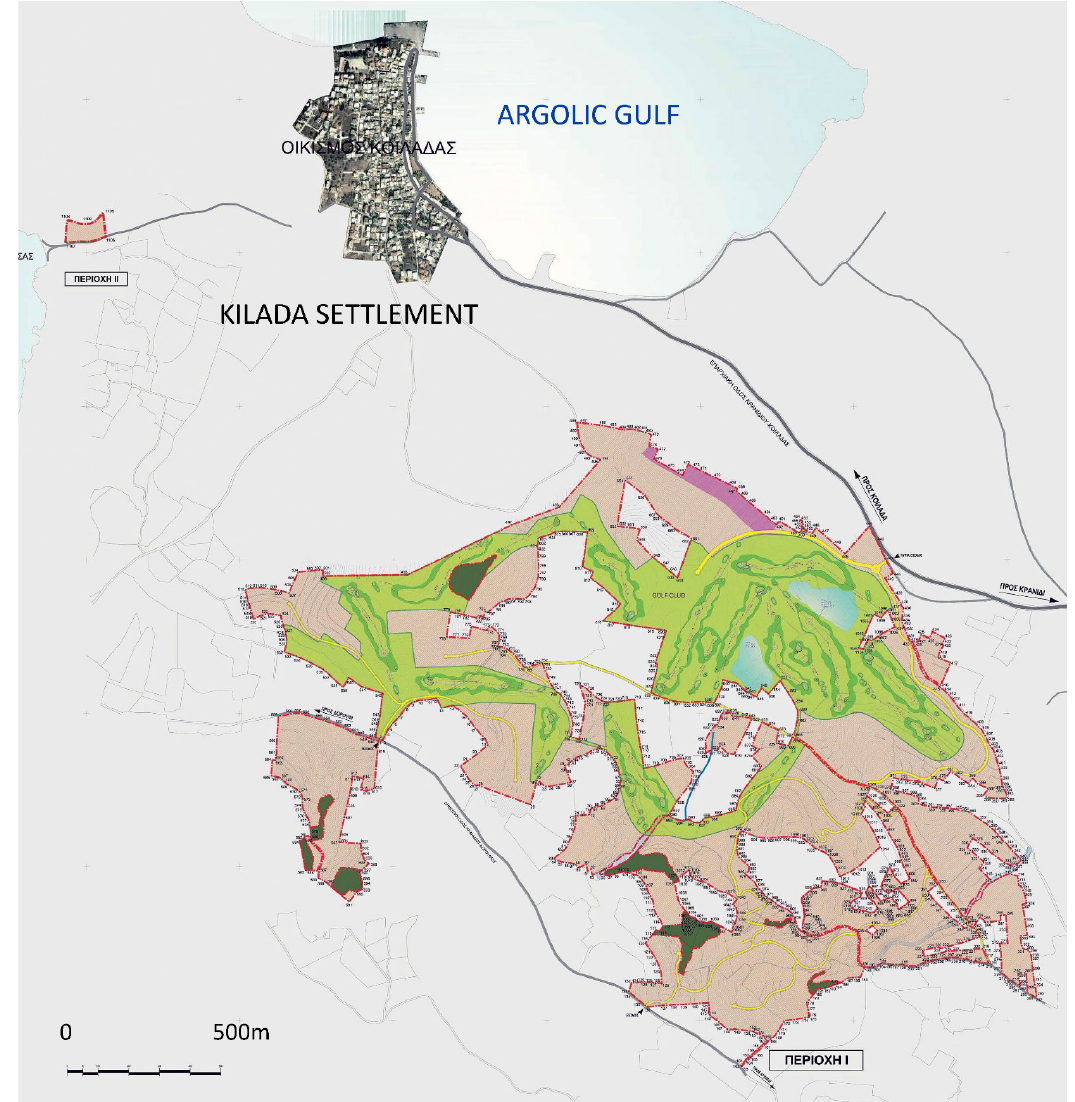
Figure 3. Killada Hills. Special Spatial Development Plan indicating the development zones (pink) and the golf course area (light green). Source: Hellenic Republic